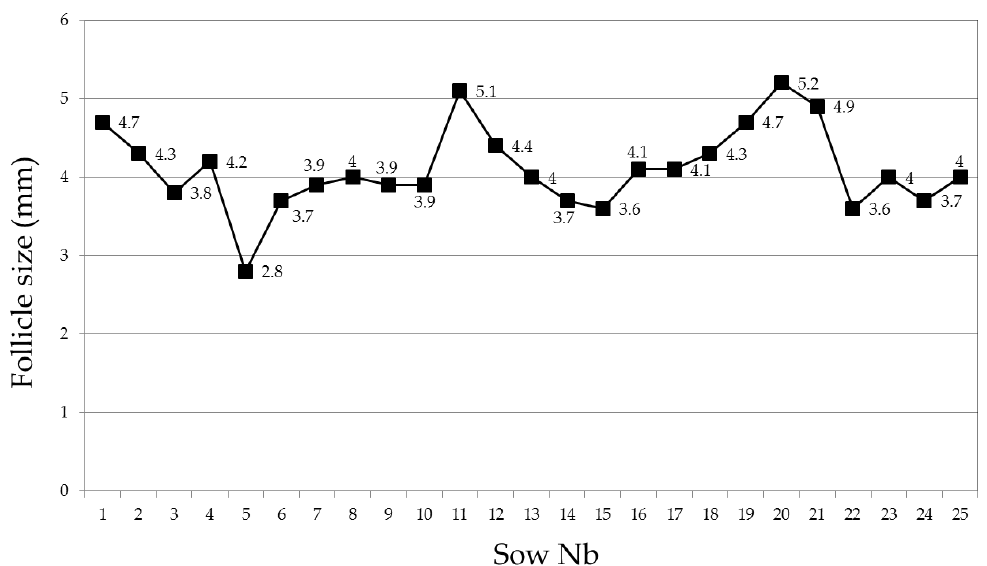
Figure 5. Follicle size of primiparous sows (n = 25) as determined by transabdominal ultrasonography one day post-weaning after 28 days of lactation [42].